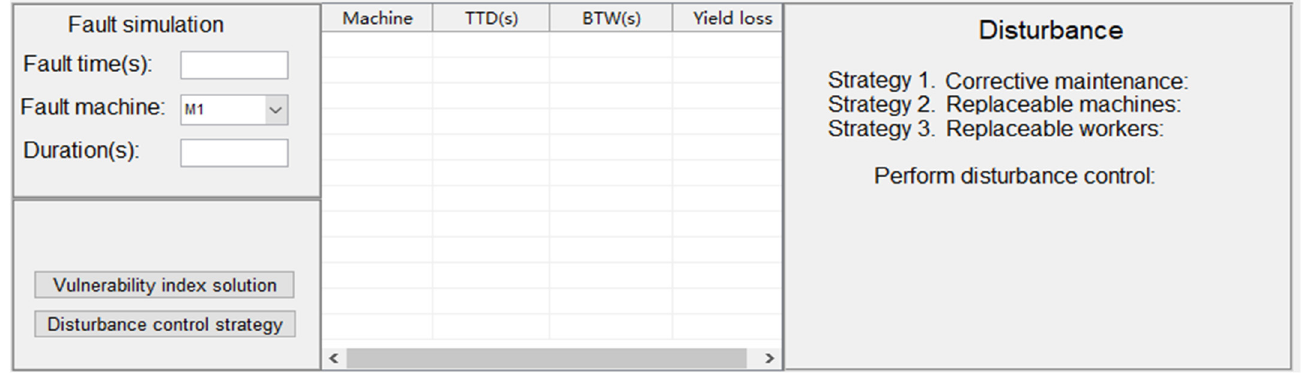
Figure 12. Introduction to the main function interface of DTS. ( a ) Digital twin interface. ( b ) Scene layout management interface. ( c ) Models’ property management interface. ( d ) Script writing inter- face. ( e ) PLC connection management interface. ( f ) Performance analysis and control interface.